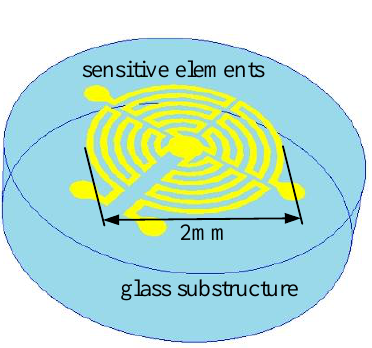
Figure 4. Results of simulation under a flow with different flow